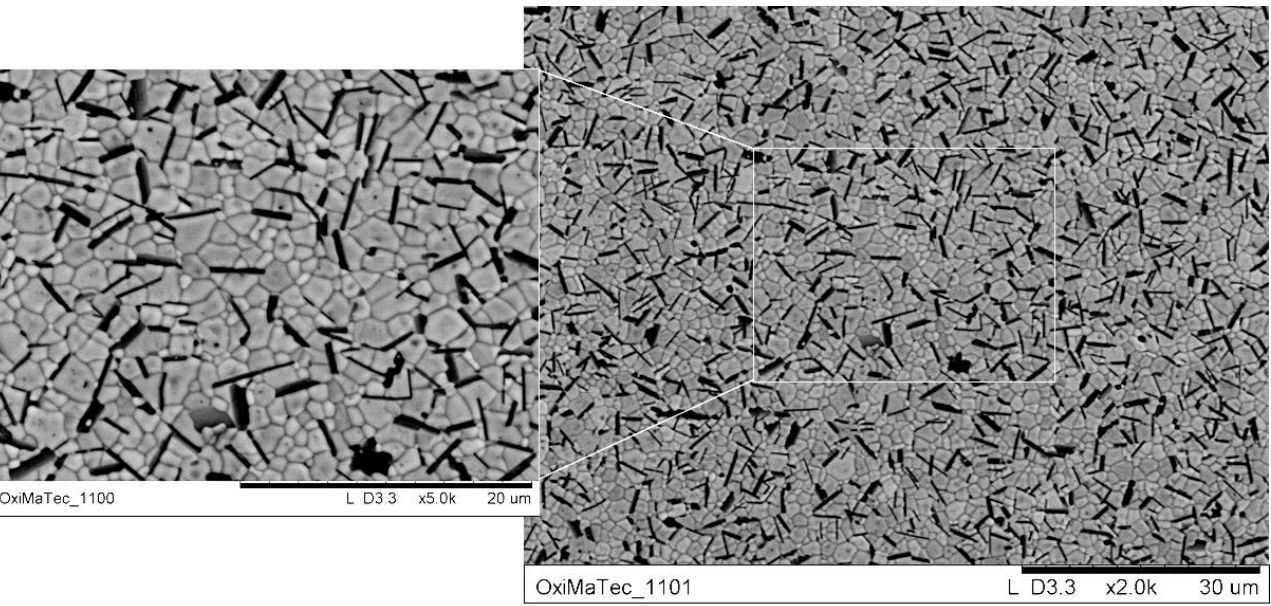
Figure 3. Microstructure of Ce-TZP/LaAl 11 O 18 composite (ZCA10P) (courtesy Dr. W. Burger, Oxymatec Gmbh, Hochdorf,